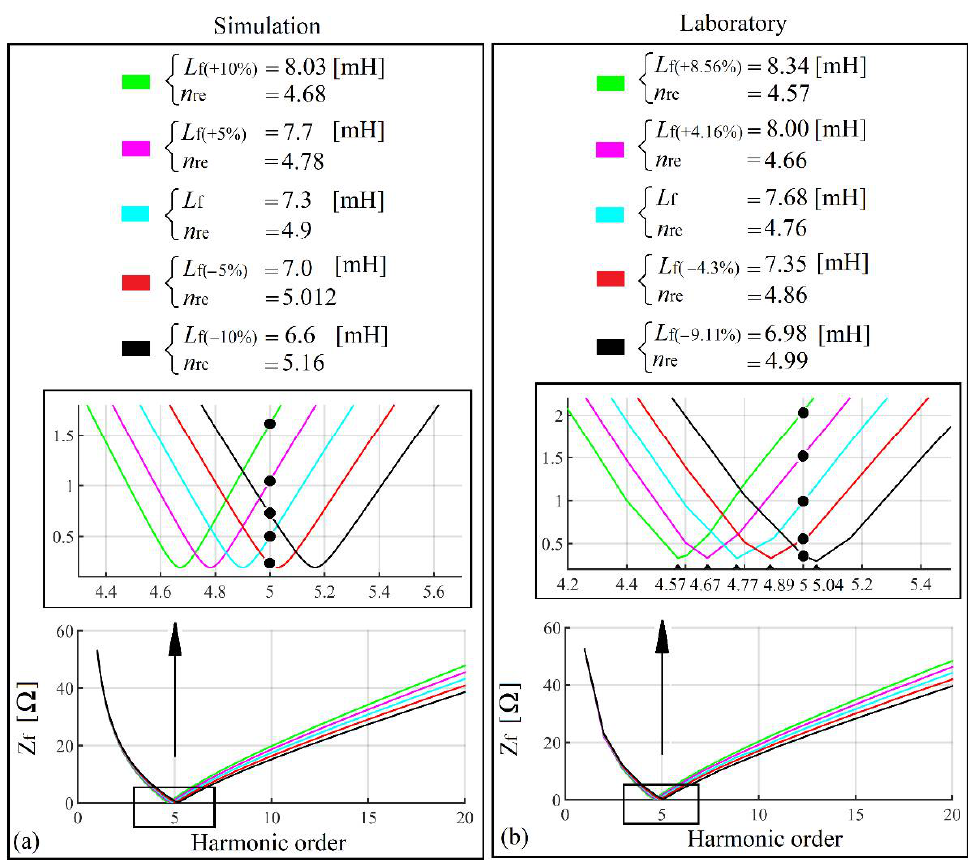
Figure 52. Power system equivalent circuit with filter reactor parameters.